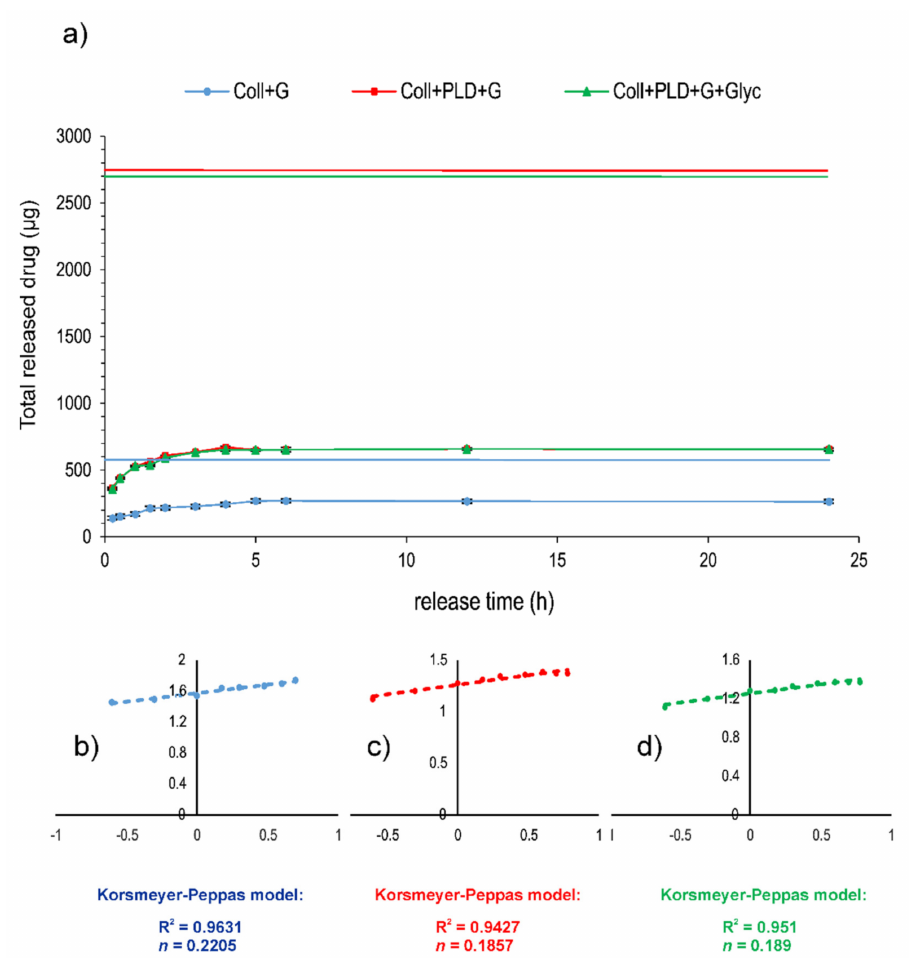
Figure 7. Profiles ( a ) and parameters ( b – d ) of gentamicin release in closed-loop system from Coll+G ( b ) Coll+PLD+G ( c ) and Coll+PLD+G+Glyc ( d ) grafts bound with the drug. Flat solid lines ( a ) indicate the total amount of drug loaded into the release cells—blue for Coll+G, red for Coll+PLD+G and green for Coll+PLD+G+Glyc,